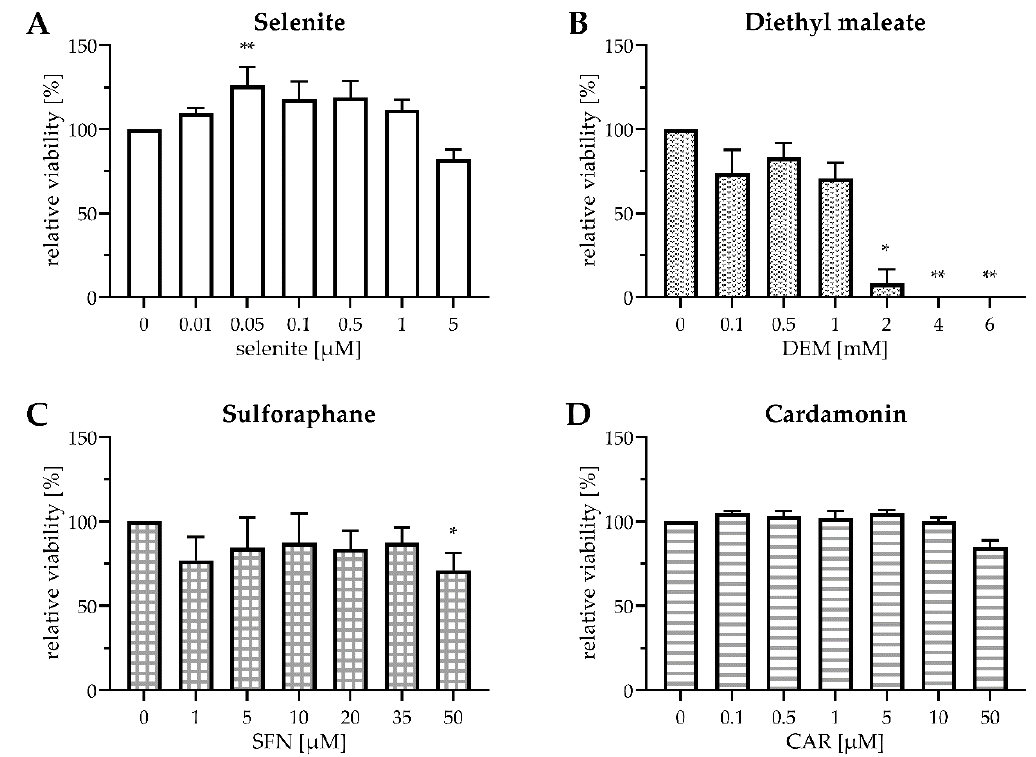
Figure 1. Viability of HepG2 cells after exposure to selenite and electrophiles for 24 h. Cells were cultured for 16 h in serum-free medium. Thereafter, they were cultured for another 24 h in serum-free medium containing sodium selenite at the indicated concentrations ( A ) or in serum-free medium containing 0.1 µM selenite and DEM ( B ), SFN ( C ), or CAR ( D ) at the indicated concentrations. Cell viability was assessed either by MTT assay ( A – C ) or by Neutral Red assay ( D ). Relative values were calculated by setting the viability of mock-treated cells to 100%. Three independent experiments were performed, each in triplicate; the data represent means ± S.E.M. Statistical analysis was done using the Friedman test and Dunn post hoc test, with * p < 0.05 vs. mock-treated cells and ** p < 0.01 vs. mock-treated cells.